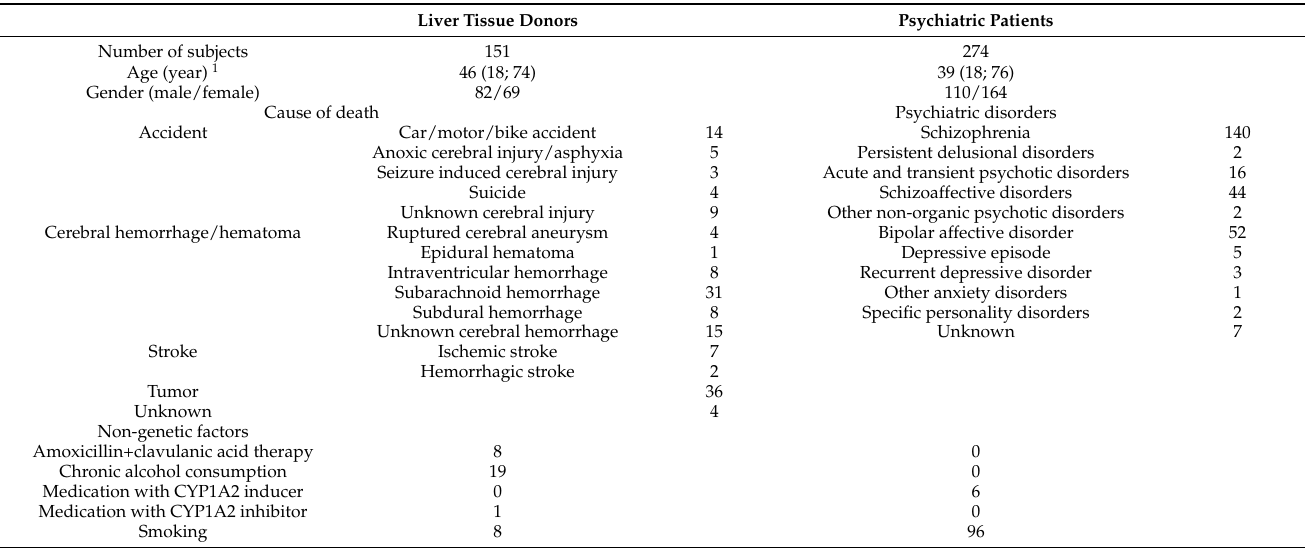
Table 1. Clinical history of the human